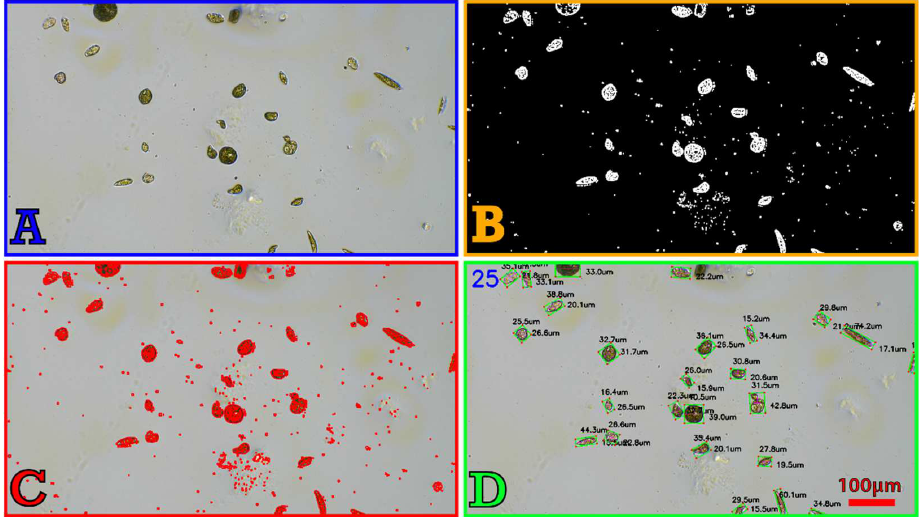
Figure 8. Image analysis process of an E. gracilis sample . An image is captured after performing the autofocus ( A ) and is converted to a binary thresholded image ( B ) used for the edge detection ( C ). The areas lower than a predefined threshold are removed and the annotation (number of cells and dimensions) are added to the image ( D ).